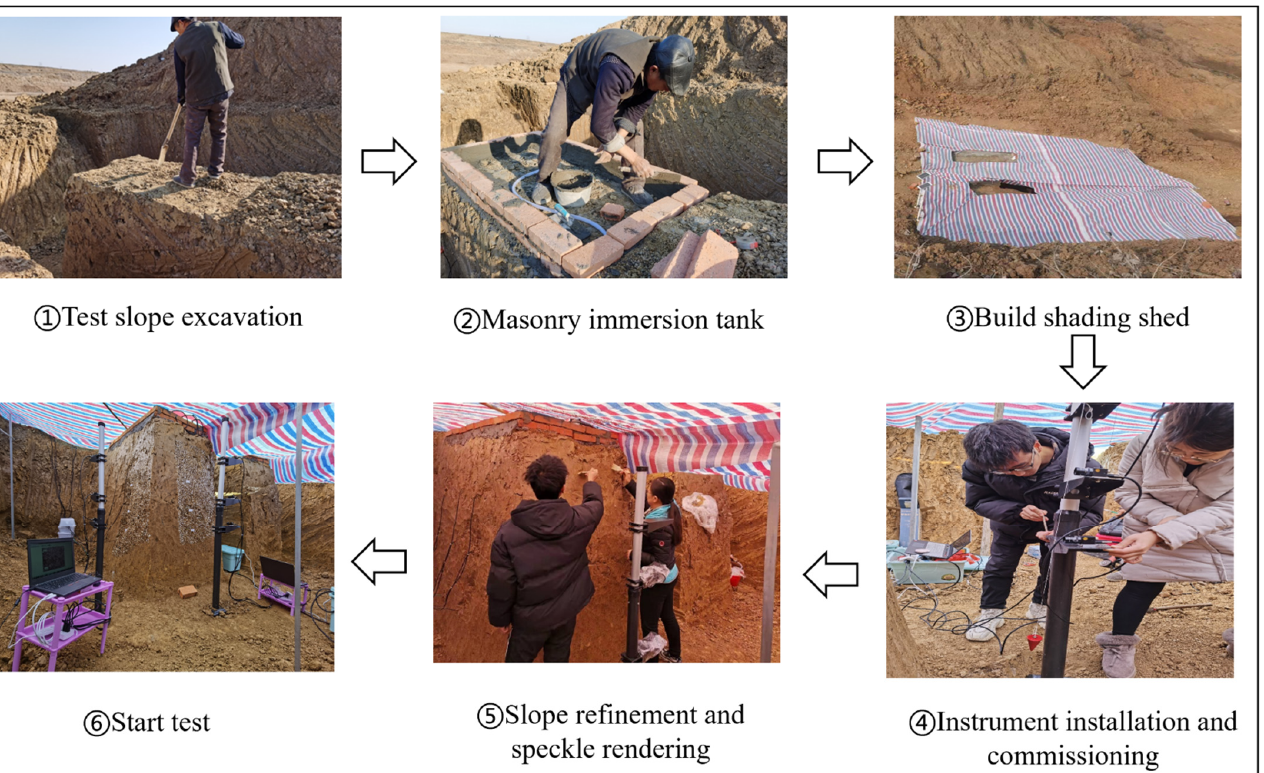
Figure 6. The main steps of the performed